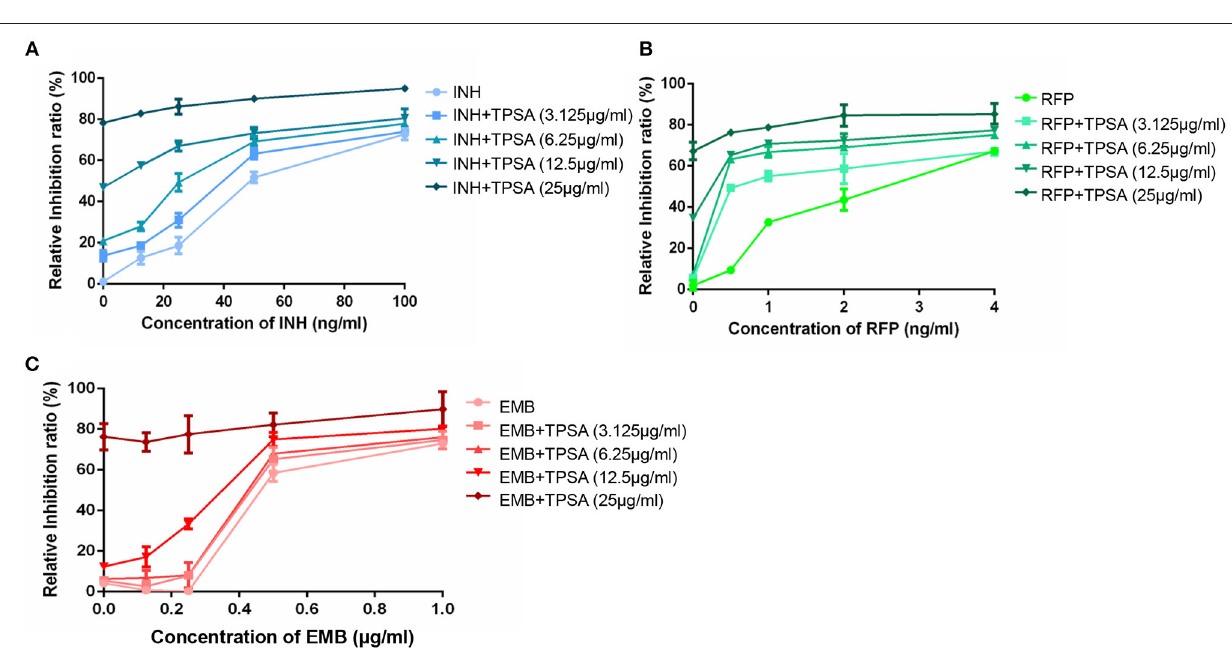
Frontiers in Cellular and Infection Microbiology |